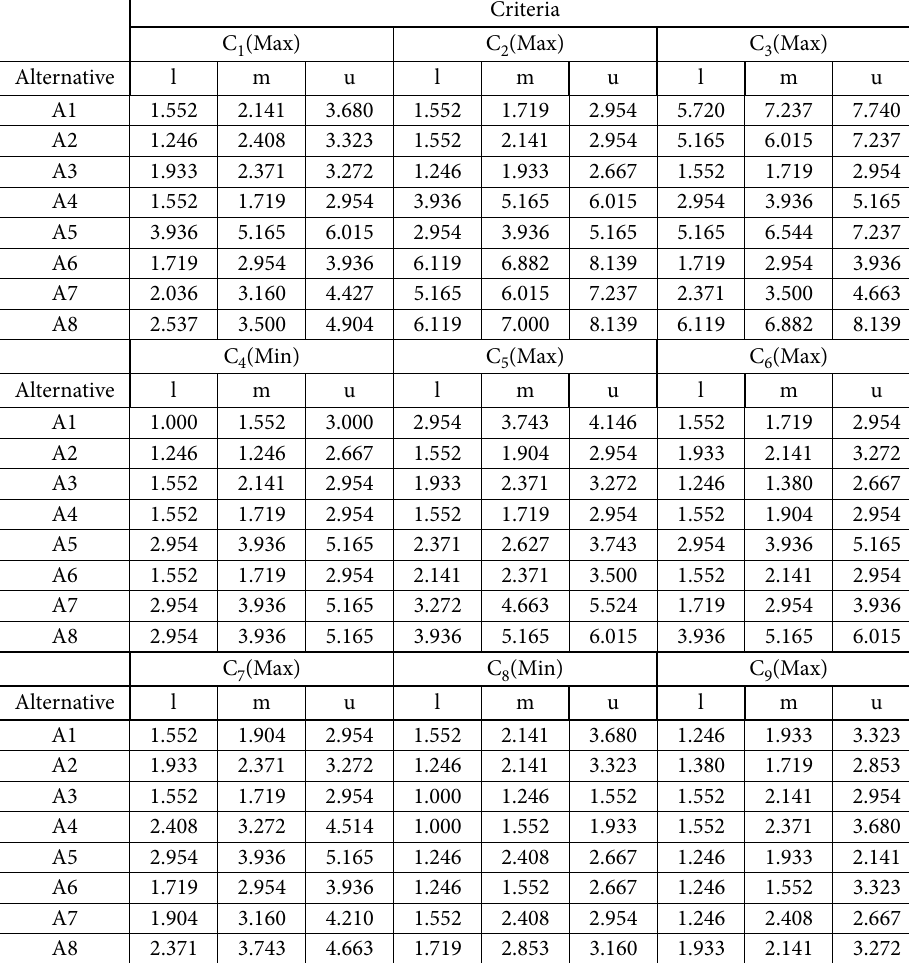
Table 8. The initial (aggregated) fuzzy decision matrix